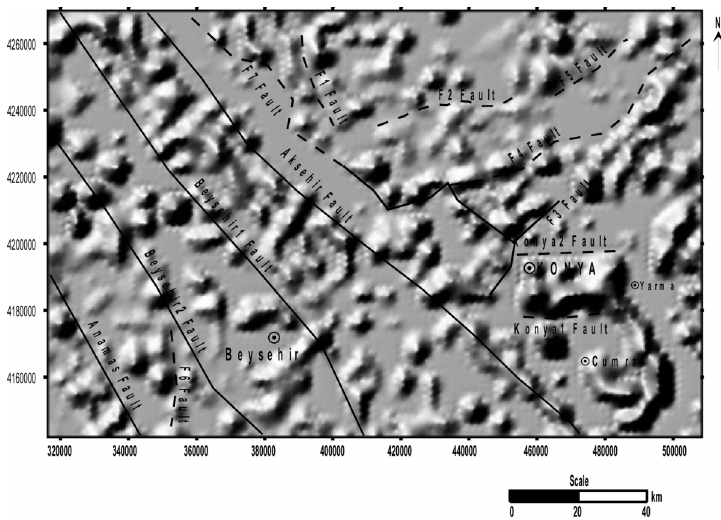
Fig. 7. Shaded Relief form of CNN output (solid lines show faults of tectonic map in fig. 5, dashed lines our proposed faults). slope (Atalay, 1975). Aksehir Fault is an active fault (Ketin, 1968; Kocyigit and Ozacar,